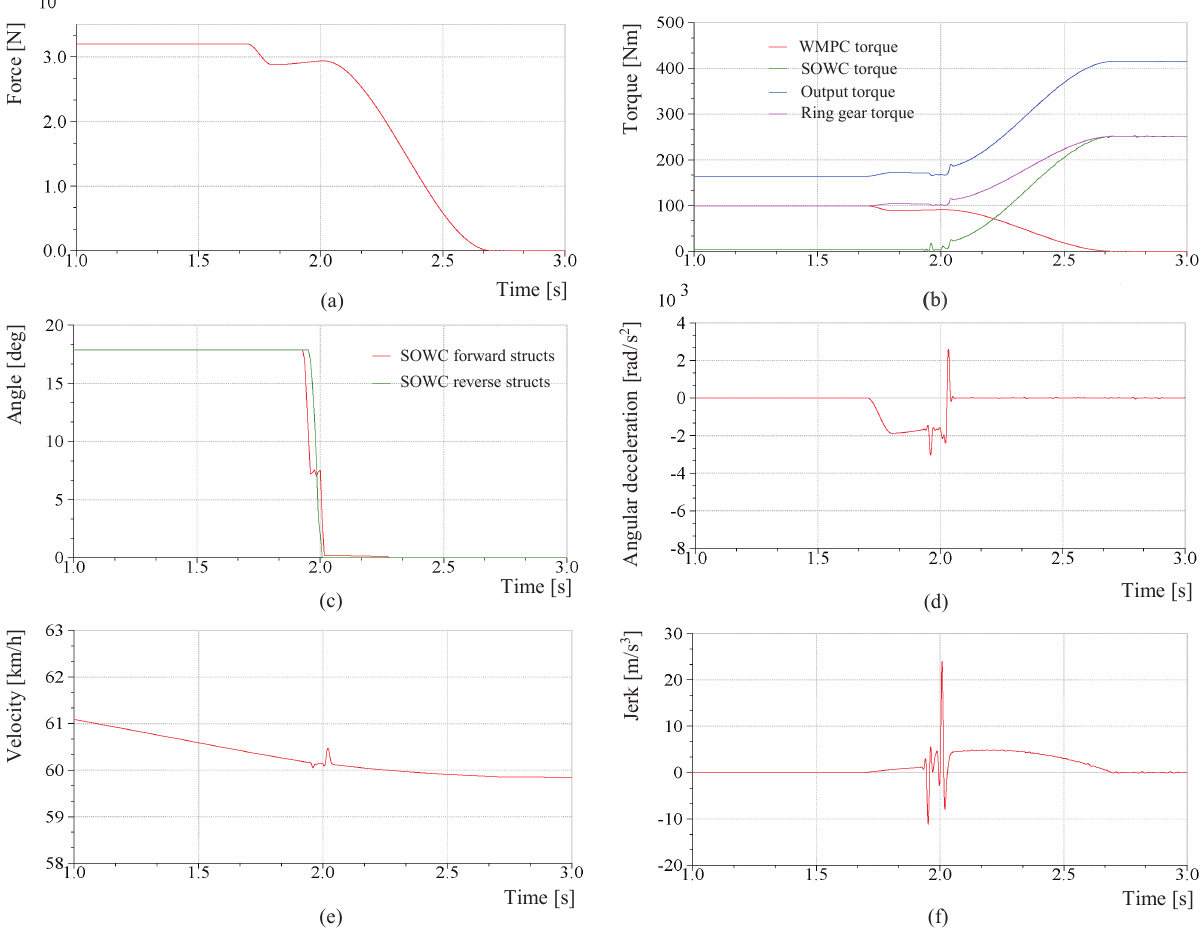
Figure 14. Simulation results of the downshifting process after the improvement of the WMPC combined curve: ( a ) Changes of WMPC pressing force. ( b ) Changes in torque transmitted by each component. ( c ) Changes of struts rotation angle. ( d ) Changes of ring gear angular deceleration. ( e ) Changes in vehicle speed. ( f ) Changes in